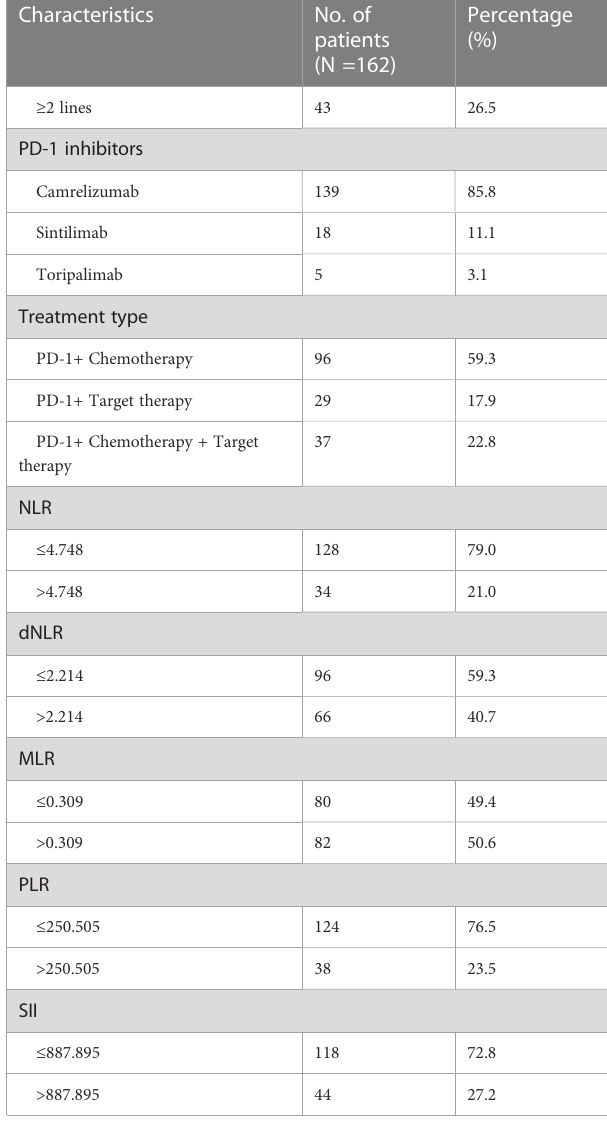
these patients. We further analyzed the changes in in fl ammatory markers in 82 PD patients. Compared to baseline, NLR (P<0.001) (Figure 4K), dNLR (P<0.001) (Figure 4L), MLR (P=0.001) (Figure 4M), and SII (P=0.024) (Figure 4O) were signi fi cantly increased when anti-PD-1 therapy failure, except for PLR (P=0.17) (Figure